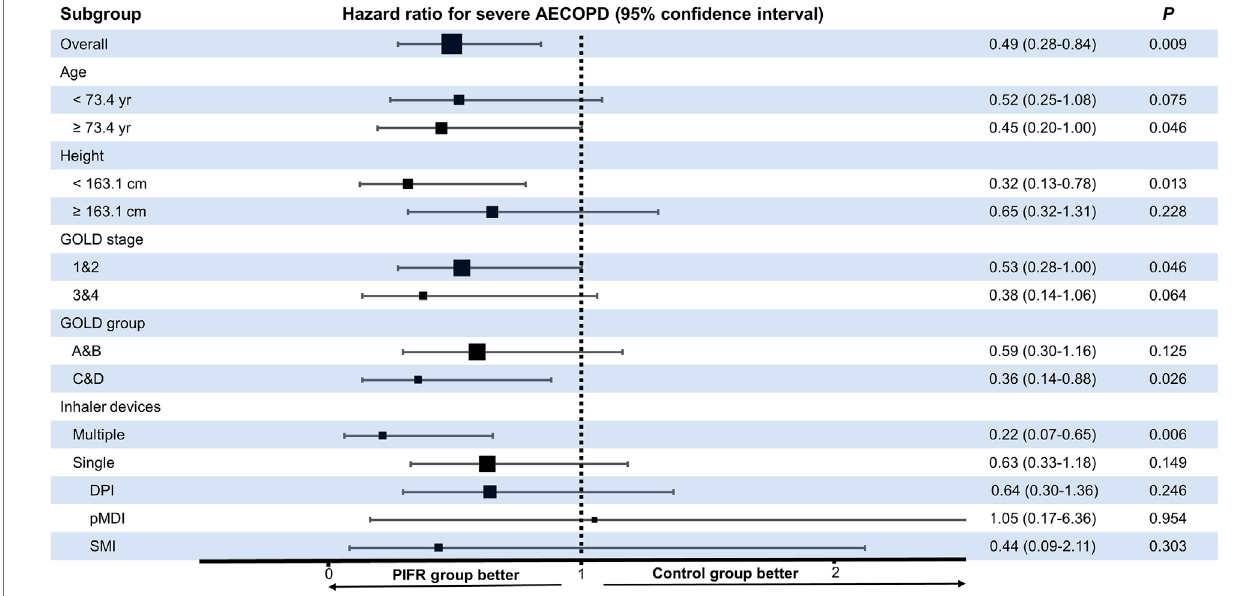
(HR (cid:1) 0.36, 95% con fi dence interval, CI (cid:1) 0.14 – 0.88, p < 0.05), and using at least two types of inhalers at the same time (HR (cid:1)